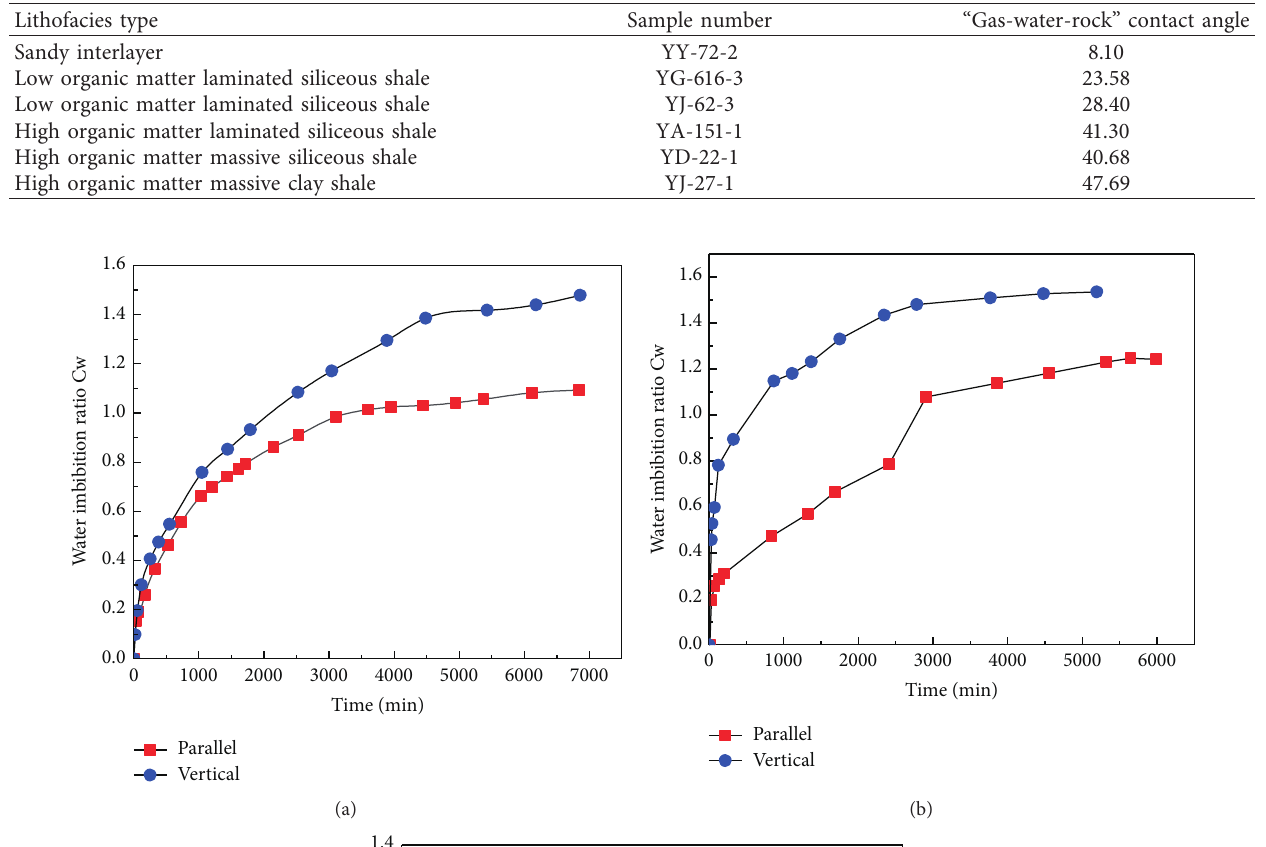
Table 3: Average values of “gas-water-rock” contact angle for different petrographic.